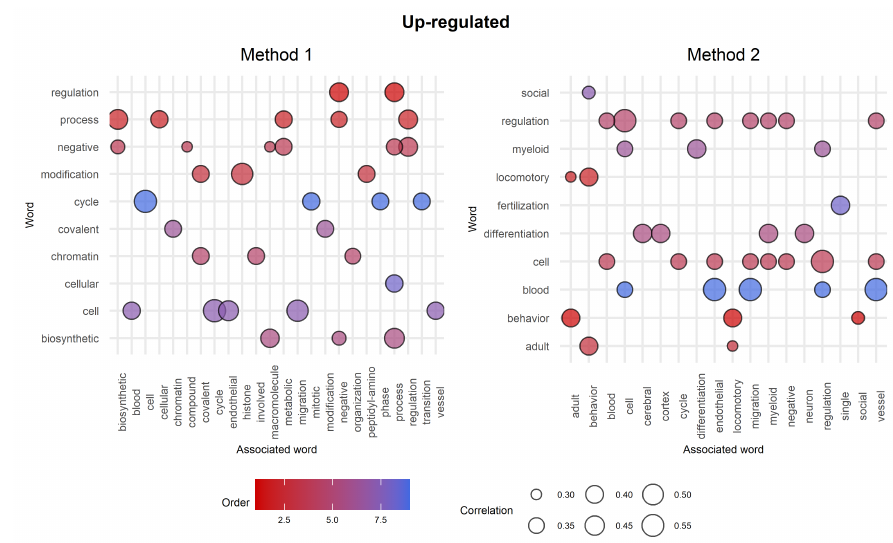
Figure 9. Correlation analysis for the top 10 words. The top 10 most significant words are represented on the y -axis, while their respective associated words are on the x -axis. The colour of the bubbles is based on the order (significance of a given GO term as described in Figure 7), whilst the size depends on the correlation between words. Note that if two top 10 words A and B are associated with each other, then the plot shows both pairs (A,B) and (B,A).